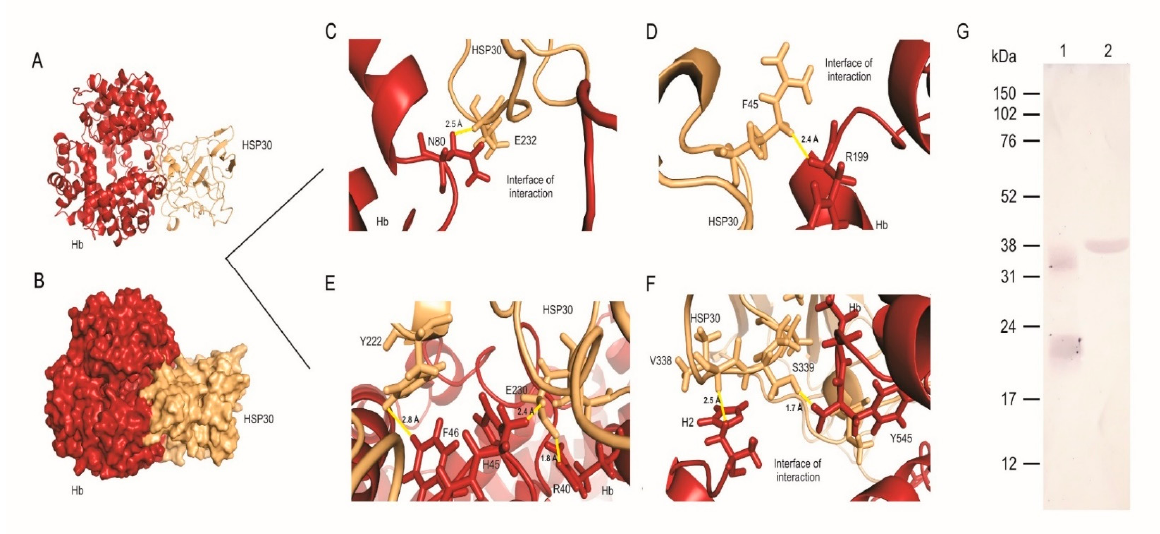
Figure 4. HSP30 is a hemoglobin-binding protein. ( A ) Cartoon view of the interaction showing the secondary structures of both proteins and the secondary structures that maintain the interface of interaction stable. ( B ) Surface view of the complex formed by HSP30 (beige) and hemoglobin (red). The interaction is maintained by a large interface of interaction between the proteins under study and by several amino acids within the interface of interaction. ( C ) Asparagine (N80) interacting with glutamic acid (E232) by a 2.5 Å hydrogen bond. ( D ) Arginine (R199) interacting with phenylalanine (F45) by a 2.4 Å hydrogen bond. ( E ) F46 interacts with tyrosine (Y222) and E230 through two hydrogen bonds, distant 2.8 and 2.4 Å, respectively. E230 also interacts with R40, distant 1.8 Å. ( F ) H2 (histidine) and Y545 interacts with V338 and S339, via hydrogen bonds distant 2.5 and 1.7 Å, respectively. ( G ) Far western analysis showing hemoglobin binding to PbHSP30. 1—Bovine hemoglobin recognition by anti-human hemoglobin monoclonal antibody. 2—Binding of hemoglobin to recombinant